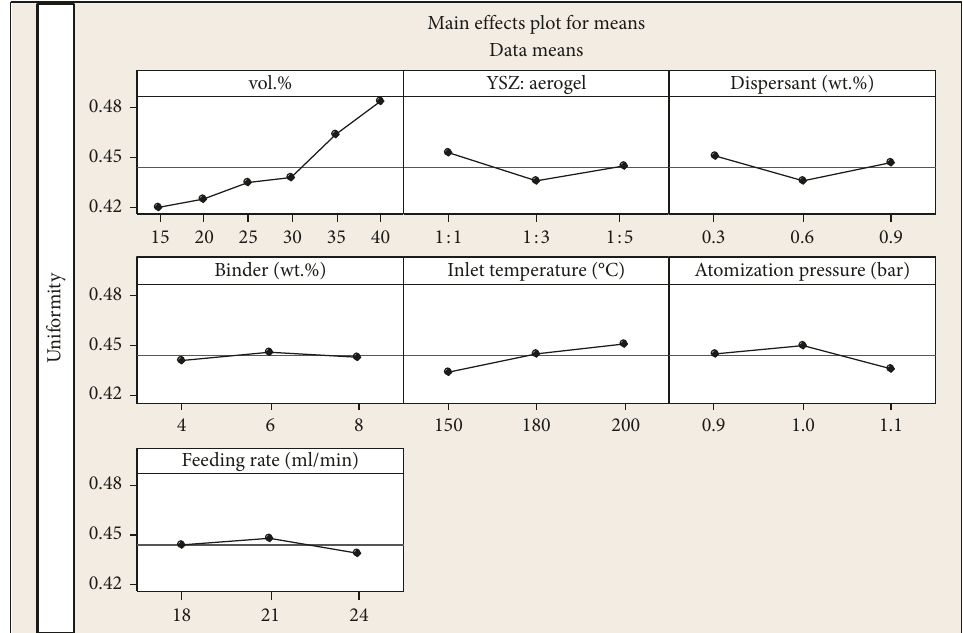
Figure 3: Effect of slurry formulation and granulation variables on uniformity of YSZ-aerogel spray-dried powder.